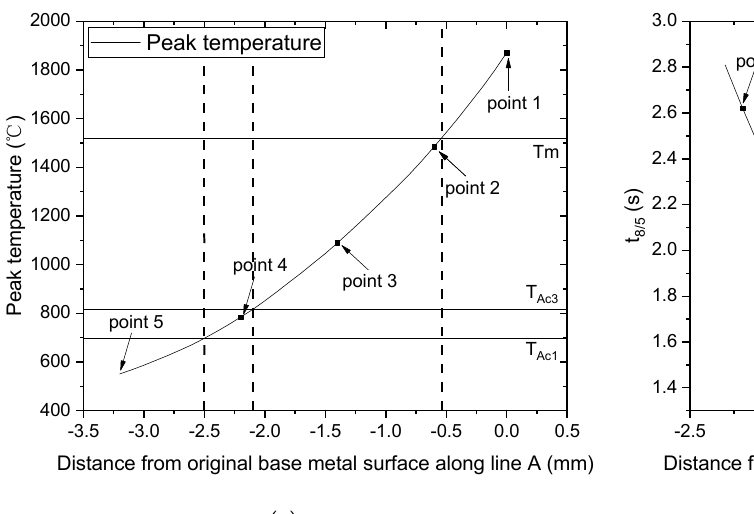
Figure 9. ( a ) Peak temperature and ( b ) t 8/5 along the line A in Figure 4. Referring back to Figure 4, points 1, 2, 3, 4, and 5 relative to the weld center line were